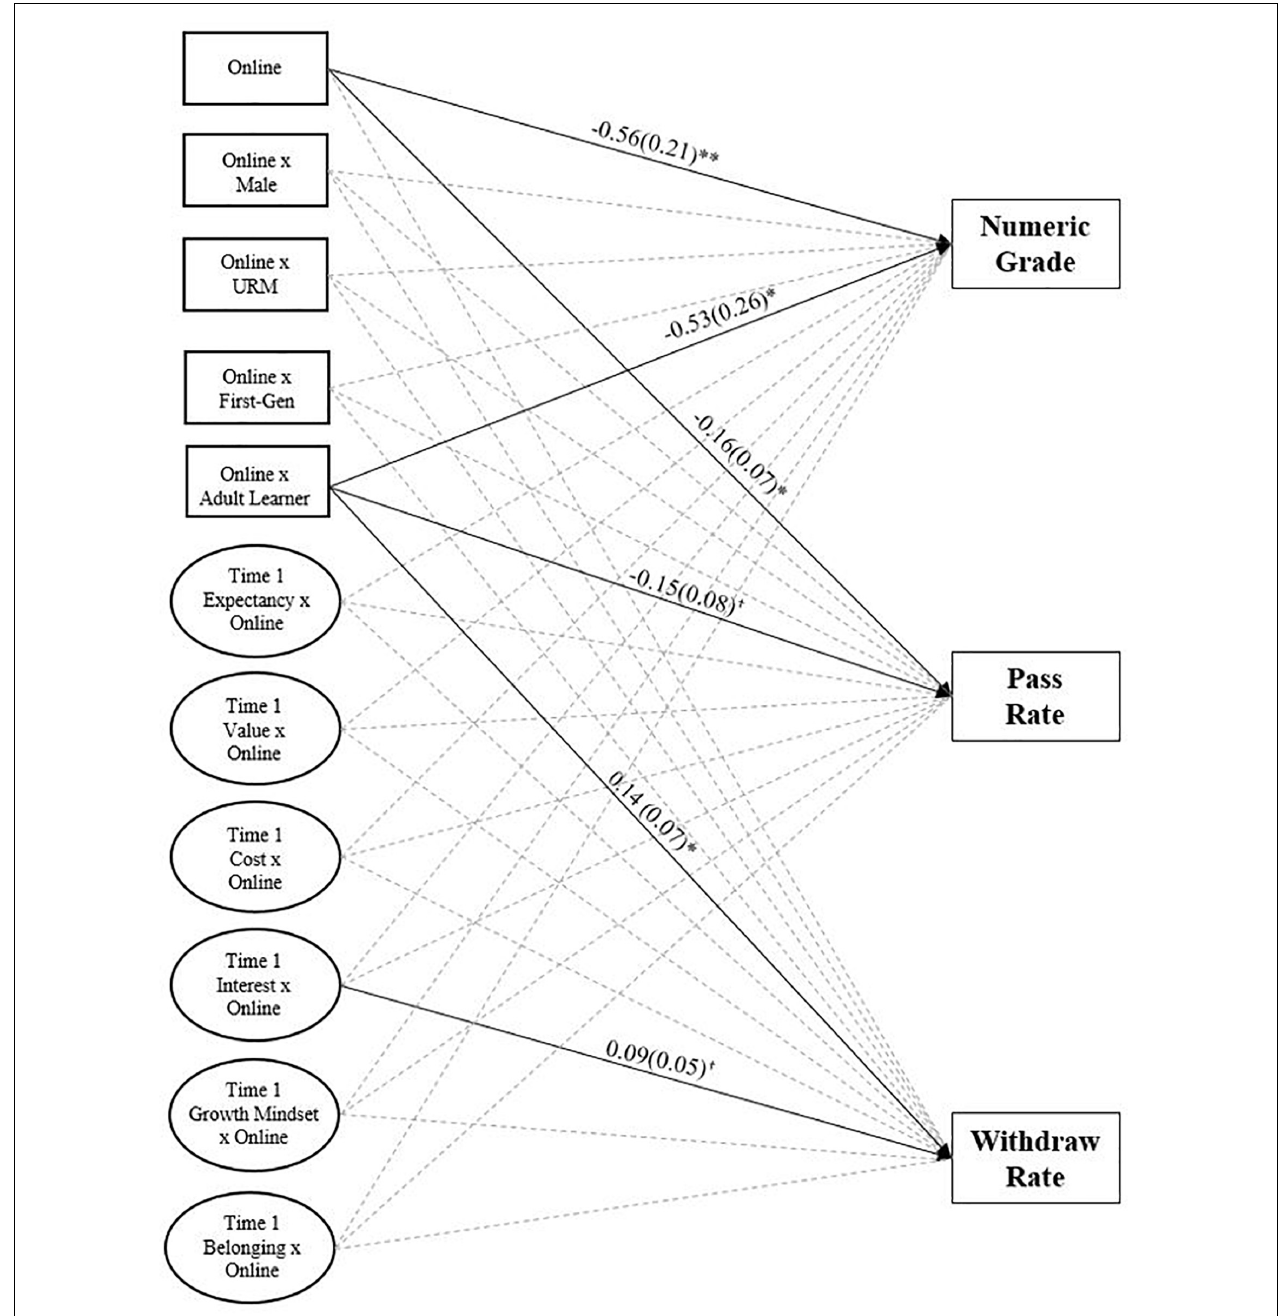
FIGURE 1 | Course modality and interactions predicting academic outcomes. † p < 0.10, ∗ p < 0.05, and ∗∗ p < 0.01.